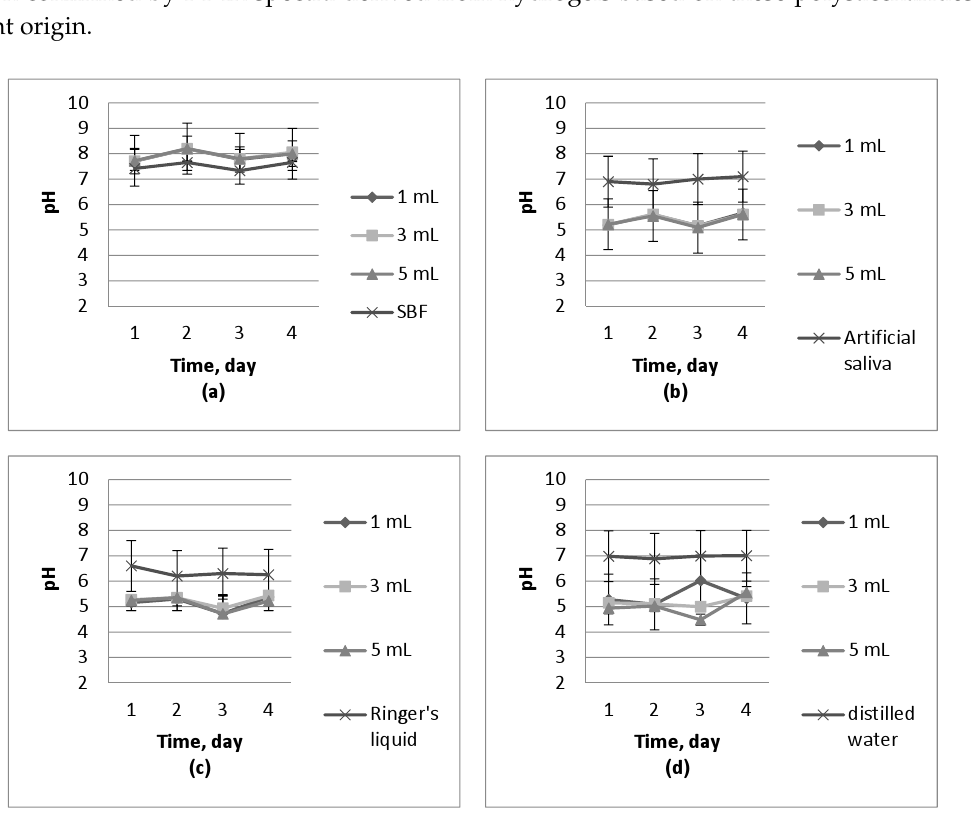
Figure 3. Incubation of Beetosan ® hydrogels in: ( a ) SBF; ( b ) artificial saliva; ( c ) Ringer’s liquid; and ( d ) distilled water.